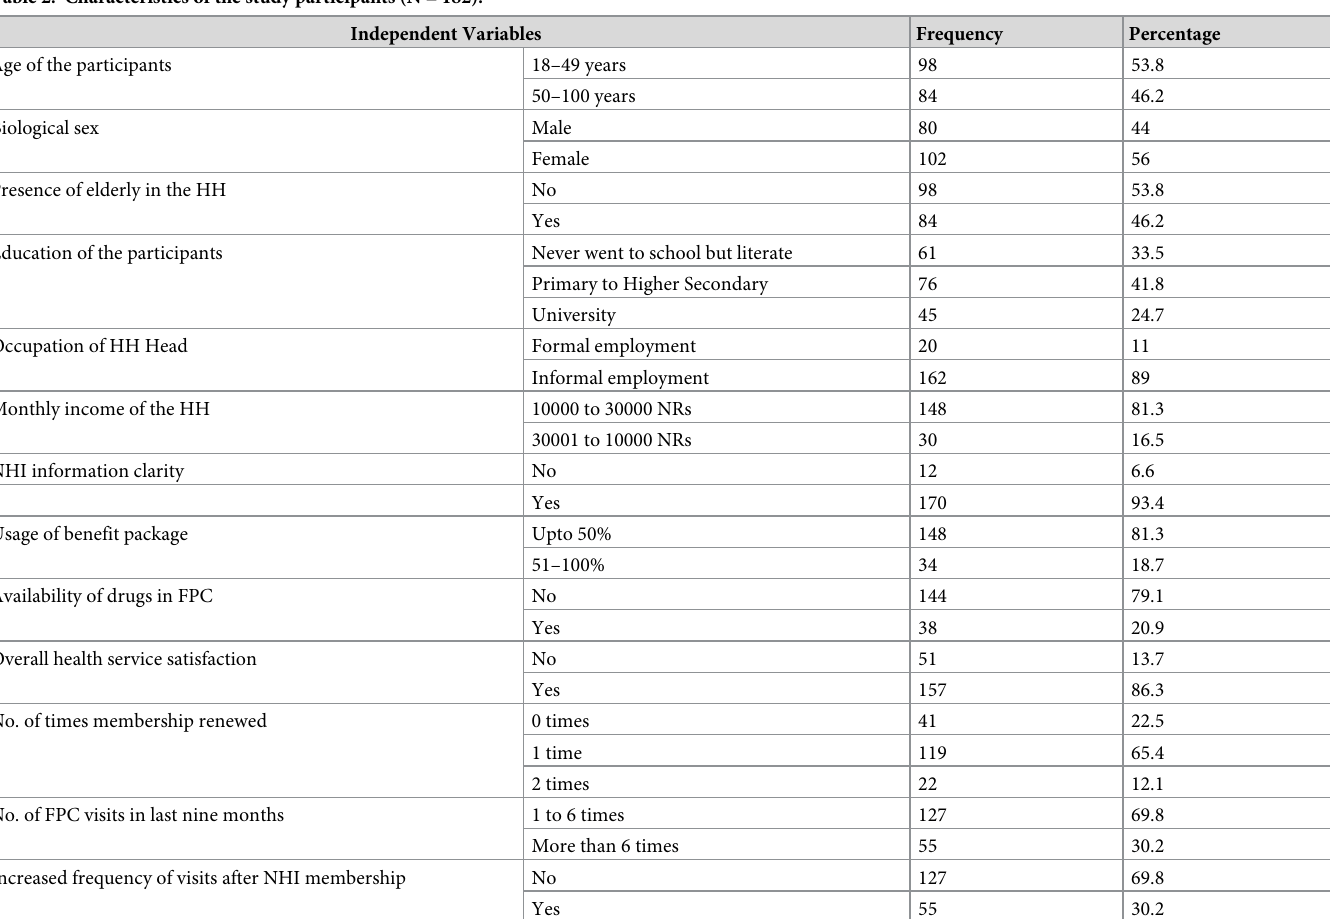
Table 2. Characteristics of the study participants (N =